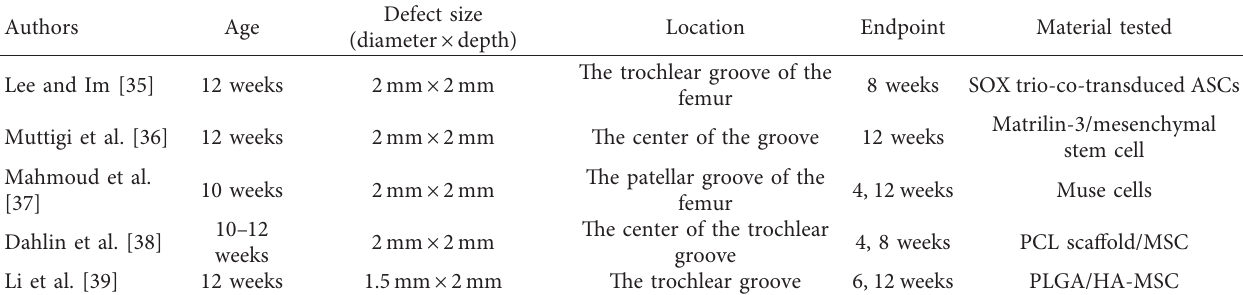
Table 2: Examples of studies using rat osteochondral defect models.